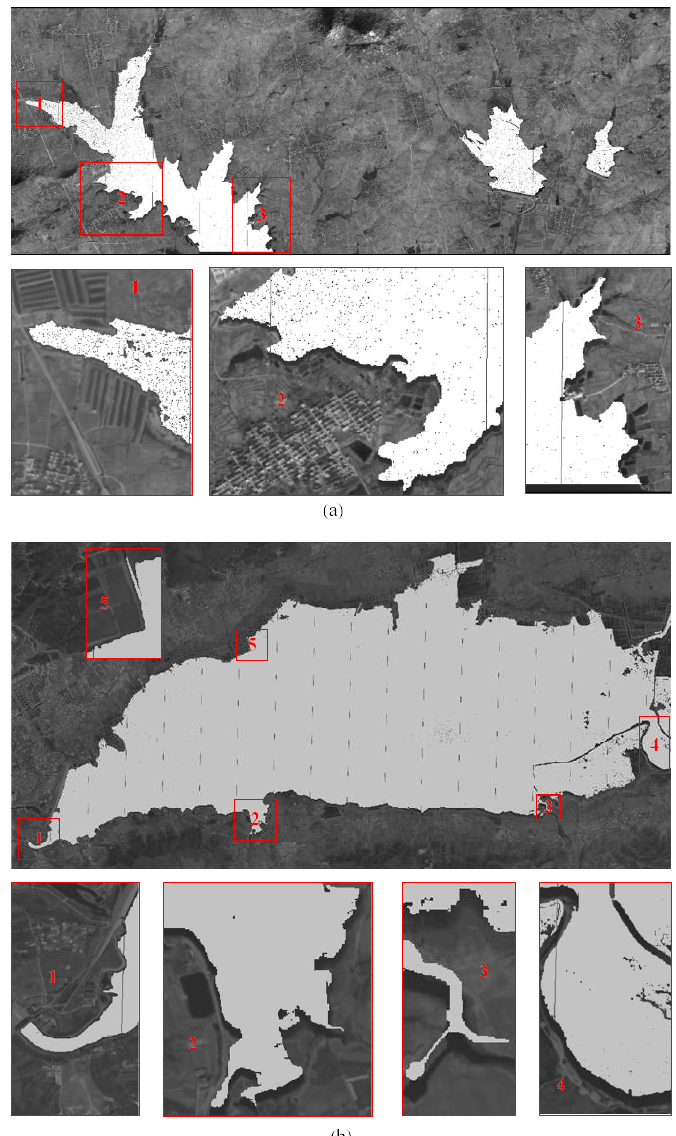
Figure 10. Left image ROIs were embedded into right image. ( a ) Image pair block 1. ( b ) Image pair block 2.